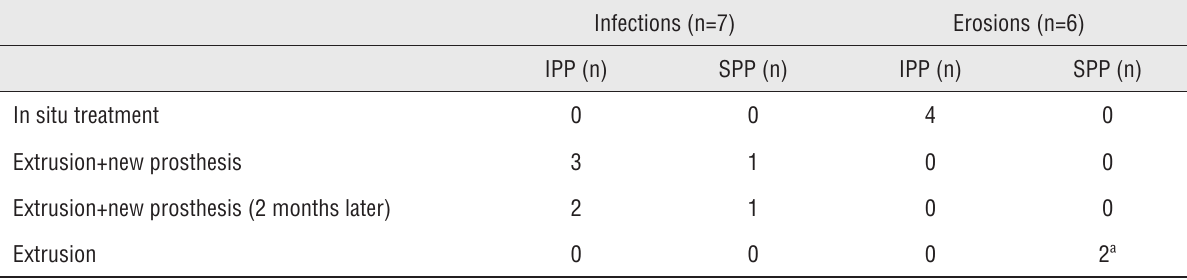
Table 2 - Management of infections and erosions.